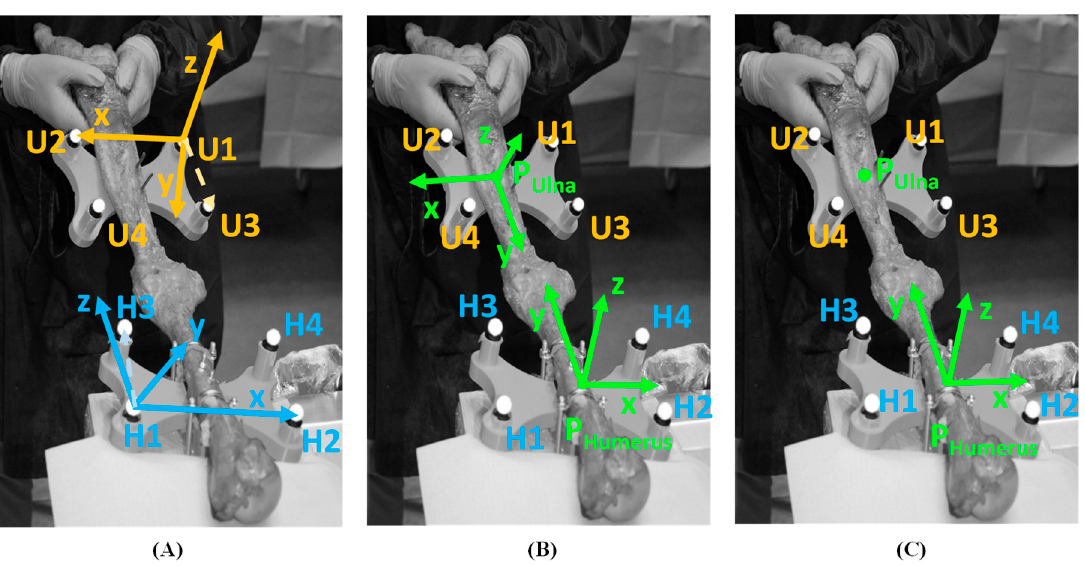
Figure 2. Marker clusters reference systems ( A ); ulna reference frame and humerus reference frame ( B ); ulna origin P Ulna positioning with respect to humerus frame ( C ).